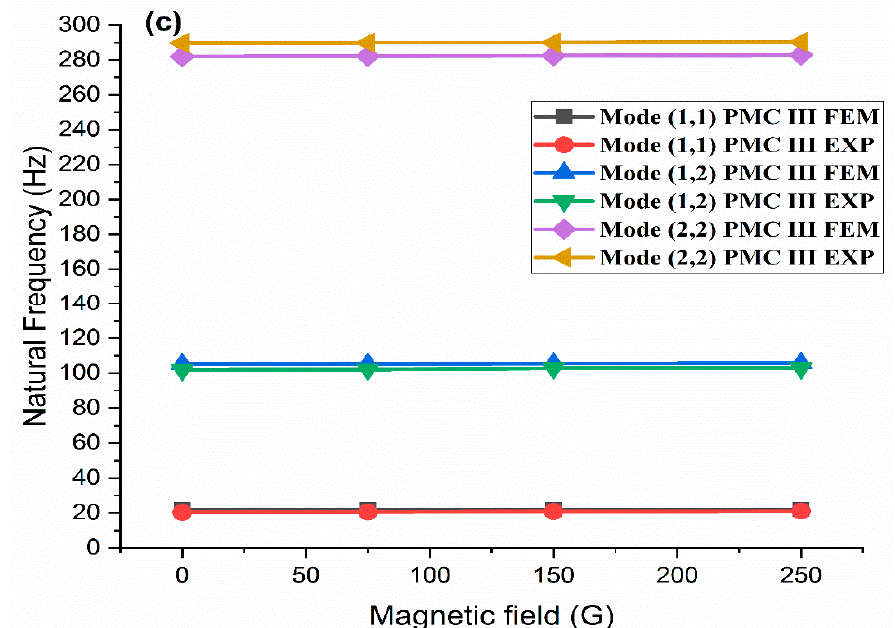
Figure 22. The effect of MRE size on the natural frequencies of different partially treated tapered composite sandwich configurations under different magnetic fields for ( a ) PMC I, ( b ) PMC II, and ( c ) PMC III.